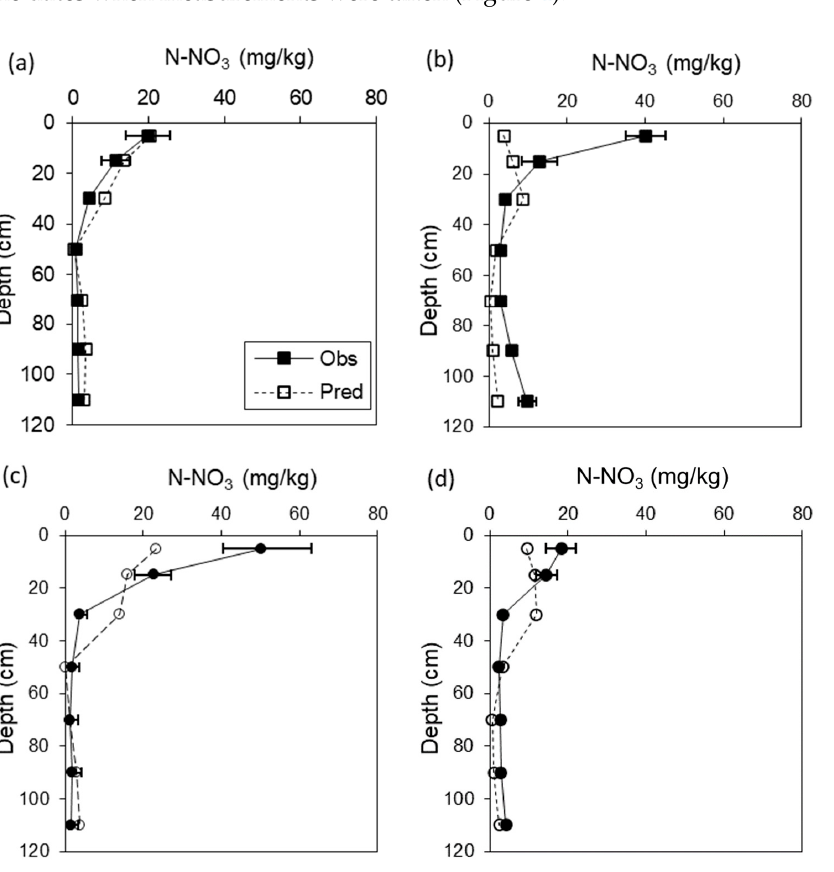
Figure 4. Observed (Obs) and predicted (Pred) soil nitrate concentrations at Maindample ( a ) and Ruffy ( b ) for the Medium ( c ) and High systems ( d ) at the end of the SGS experiment (26/04/2001 at Maindample; 30/4/2001 at Ruffy). Predicted data are the mean of the data 3 days before and 3 days after each date. Points indicate the mean of the observed data; whiskers indicate the standard error of the mean.